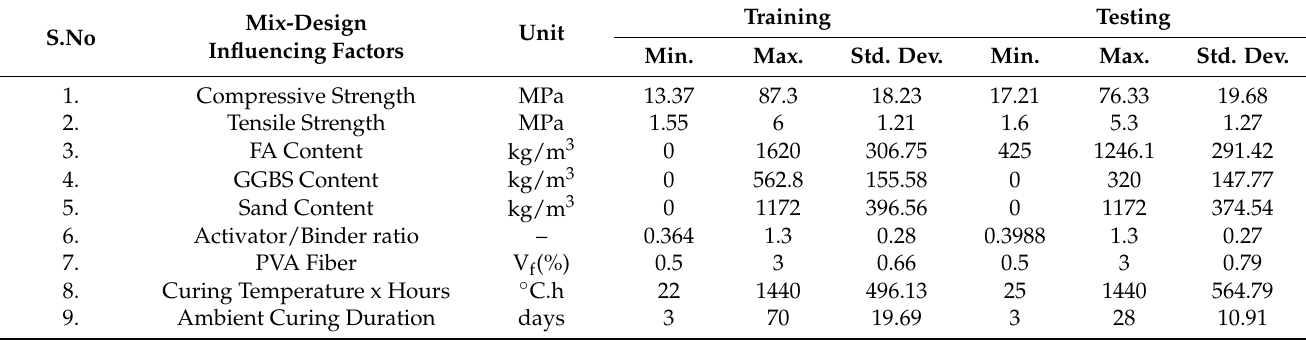
Table 2. Dataset ranges for training and testing the ANN